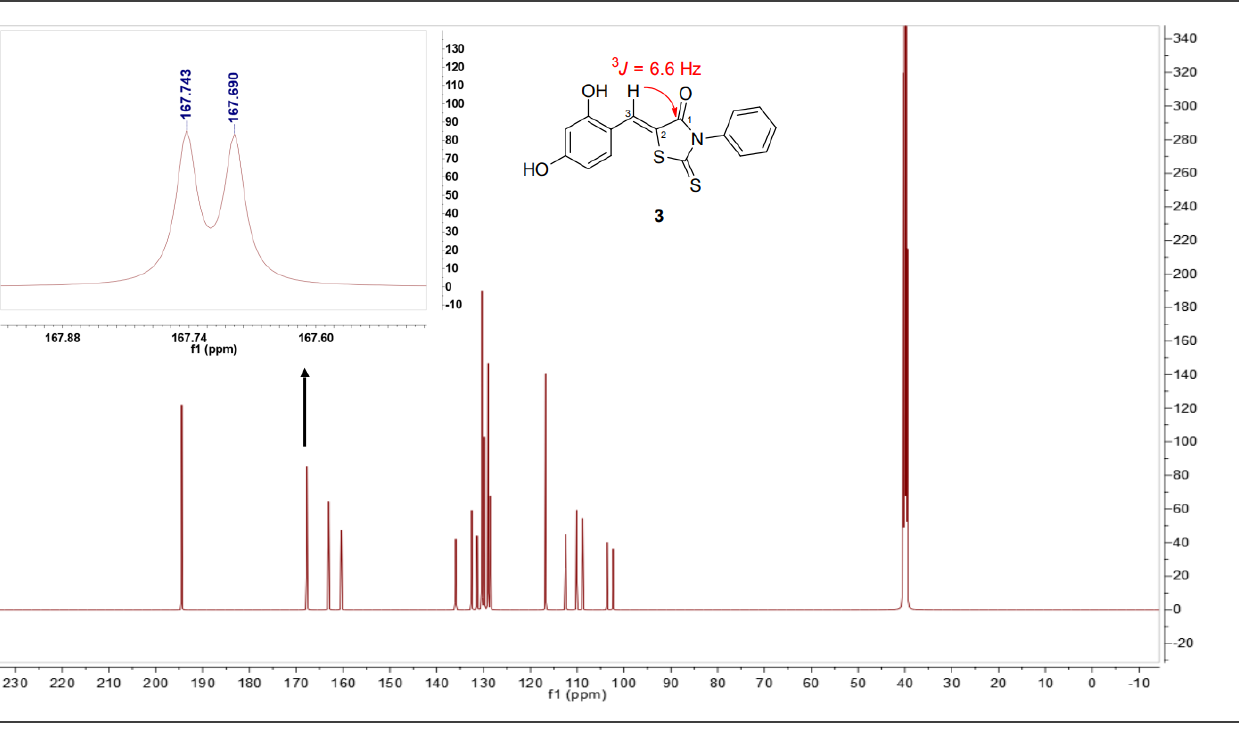
Figure 3. Proton-coupled 13 C NMR spectrum of ( Z )-BPTT analog 3 showing the vicinal 1 H, 13 C-coupling constant ( 3 J ( C (1), H -C(3)) ) of C1.